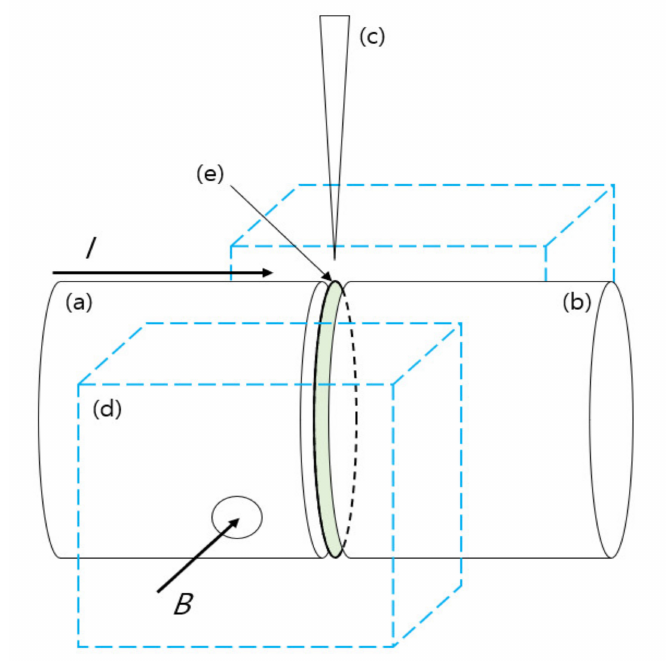
Figure 1. Configuration diagram of superconducting arc-induction type DC circuit breaker (arc breaking part). a—Anode; b—Cathode; c—Induction needle; d—Superconducting magnets;